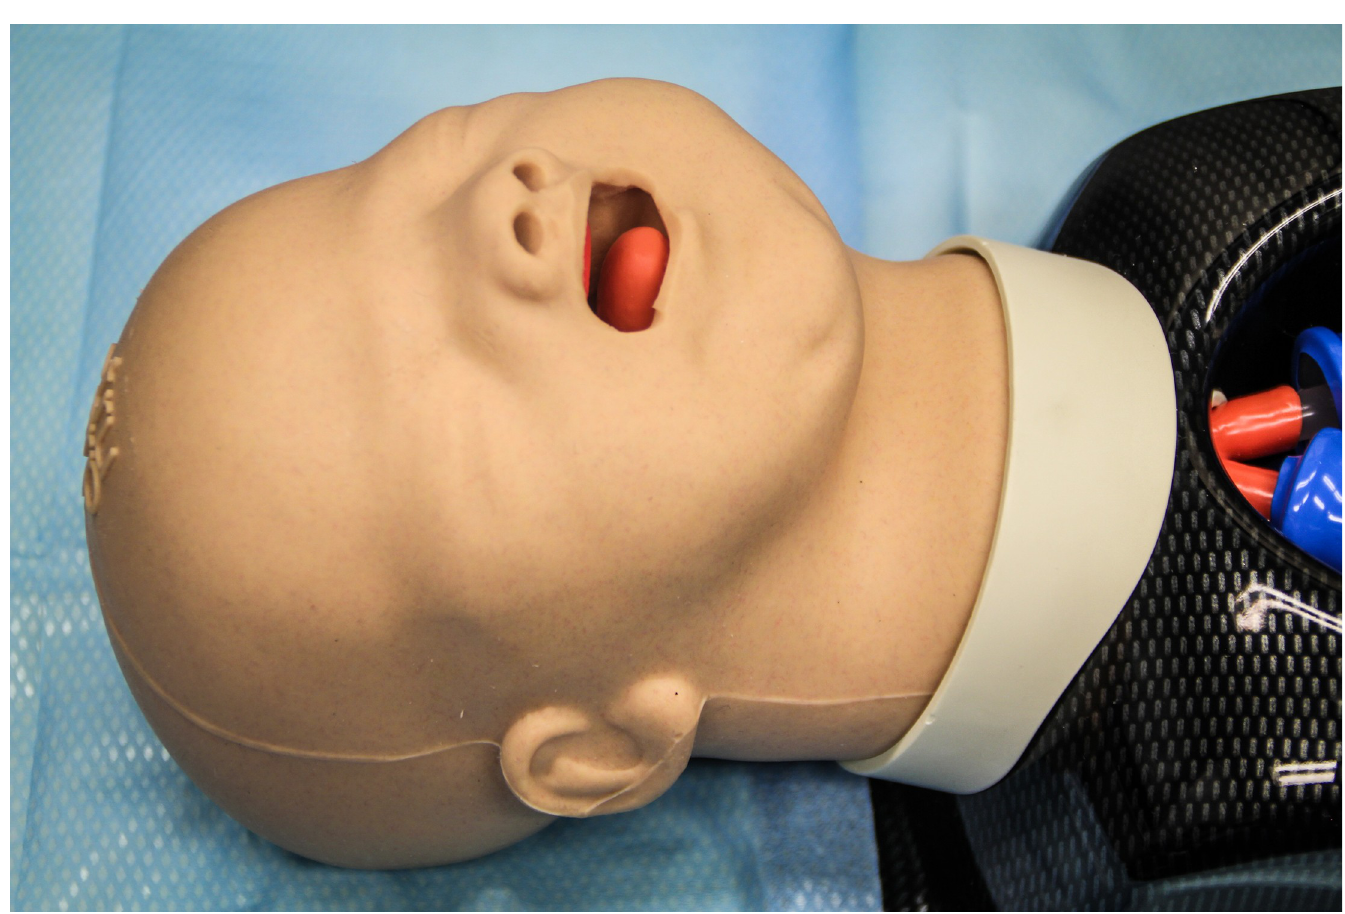
Fig 2. AirSim 1 Pierre Robin X manikin. The manikin represents the anatomically correct airway of an infant with Pierre Robin syndrome.